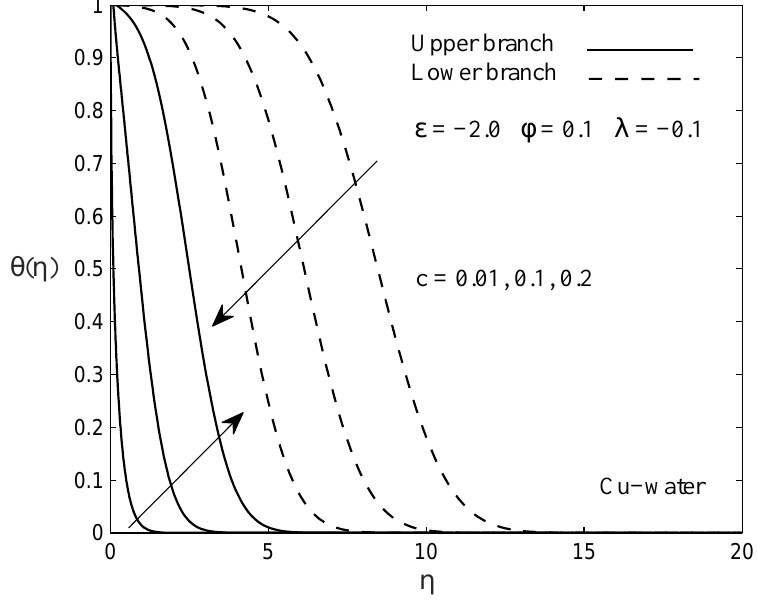
Figure 11. Effect of needle size c on the variation of temperature